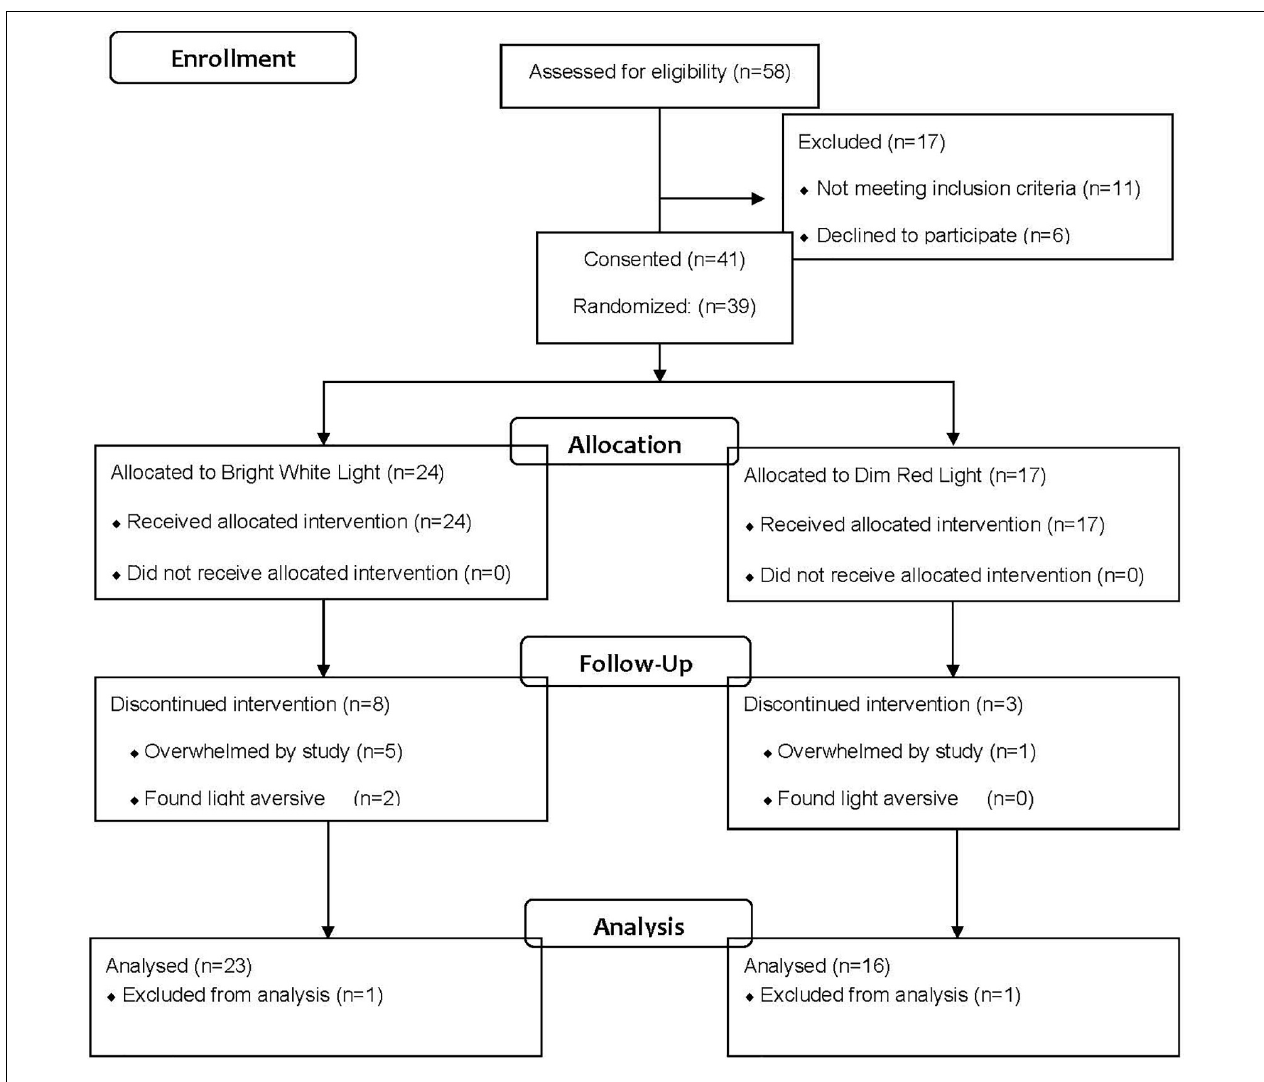
FIGURE 1 | Consort table depicting sample sizes at each point of the study.